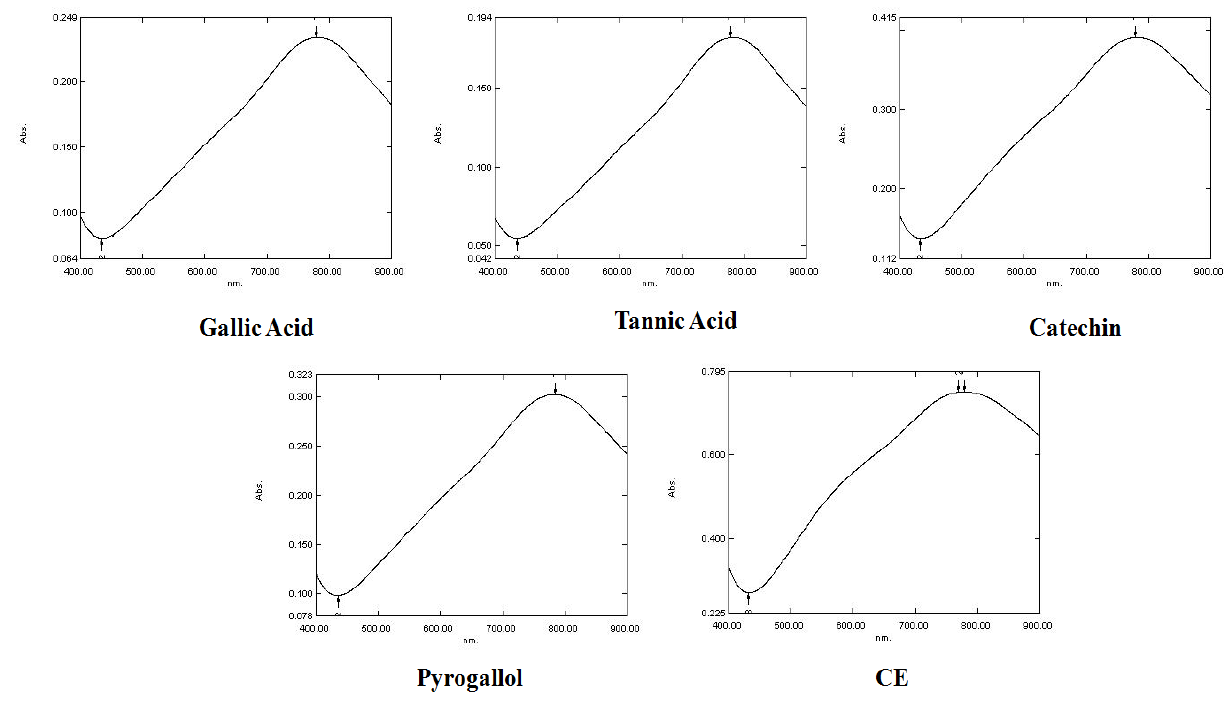
Figure 1. Absorption spectra (400 to 900 nm) of reference compounds (gallic acid, tannic acid, catechin and pyrogallol) and CE from L. brasiliense by Folin-Ciocalteu reaction after 30